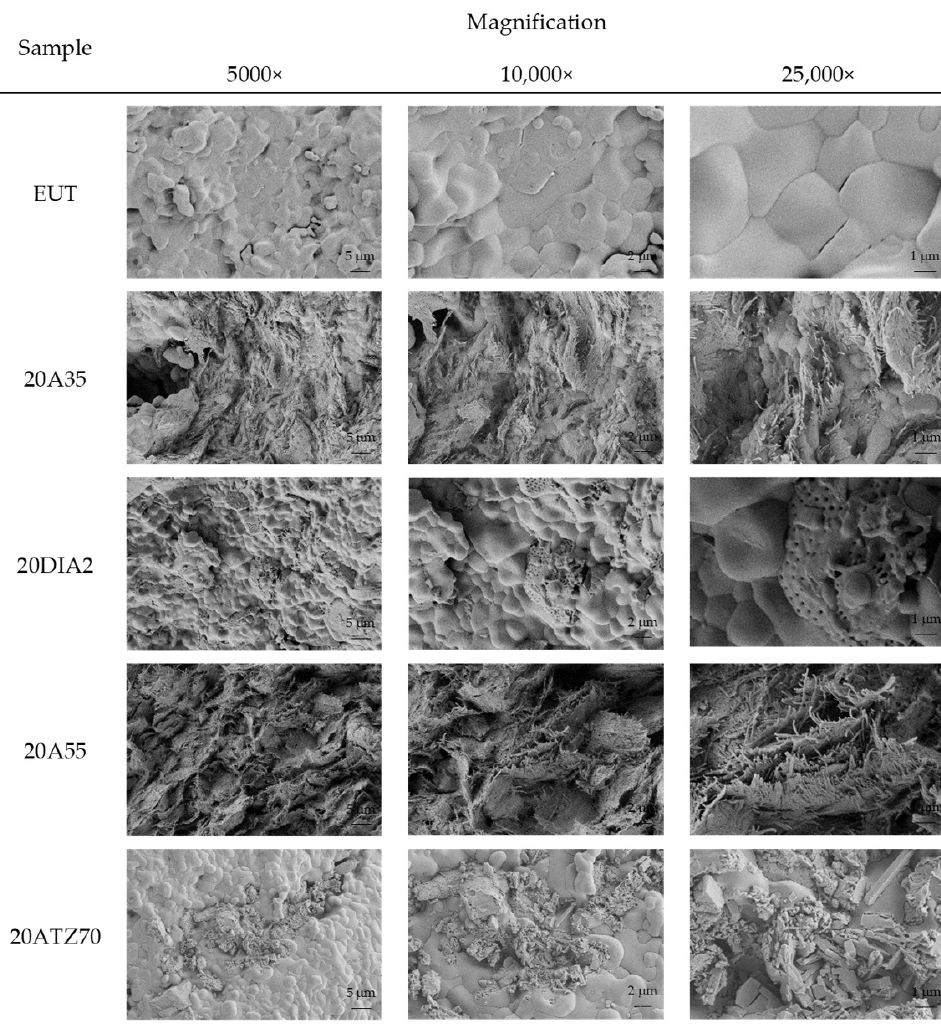
Figure 6. SEM micrographs of SSPCM (EUT-based) shape-stabilized with 20% wt. of porous